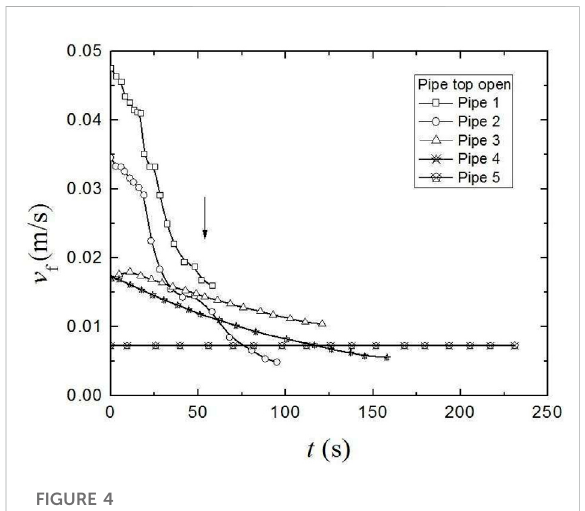
FIGURE 4 Foam risevelocity, v f ,inm s − 1 as afunction oftimeinseconds for foam columns generated within open top pipes of varying diameters. The arrow indicates the direction in which the pipe diameter increases.